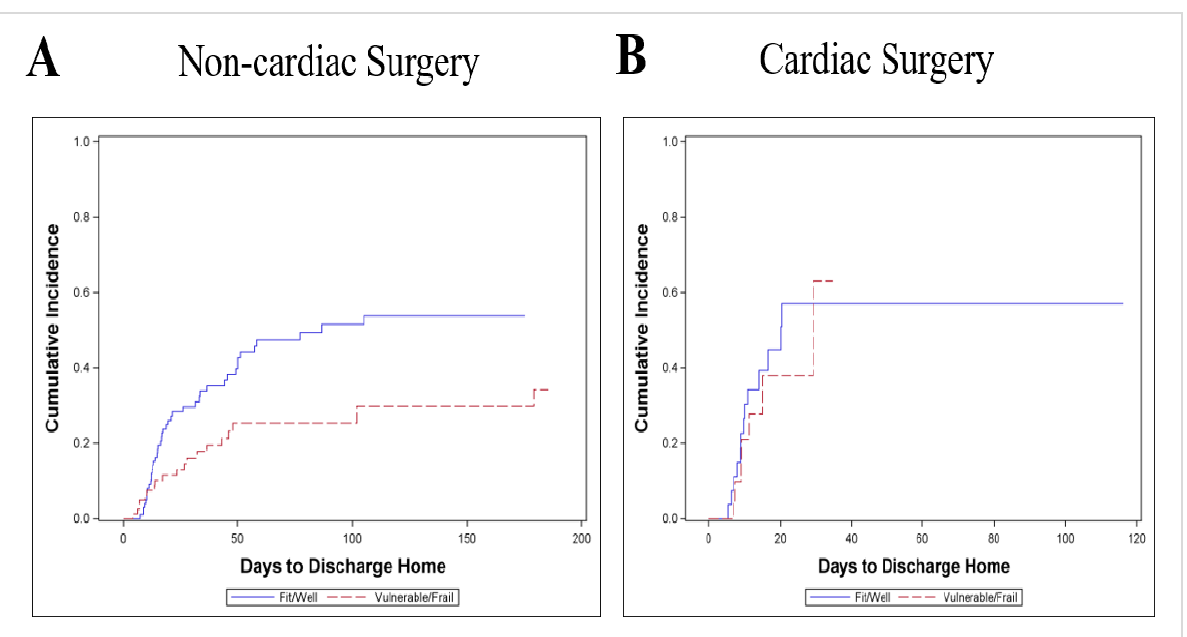
Figure A1. Cumulative incidence of discharge home comparing frail versus non-frail patients when CFS is dichotomized as vulnerable/frail (CFS ≥ 4) vs. fit/well (CFS ≤ 3); CSX = cardiac surgery. ( A ): Surgical ICU patients, n = 183 ( p = 0.006); 62 patients discharged home, 69 competing events and 52 censored; ( B ): CSX-patients n = 49 ( p = 0.61); 20 patients discharged home, 5 competing events, 24 censored.